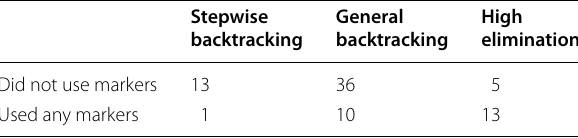
Table 9 Marker use by strategy group in Study